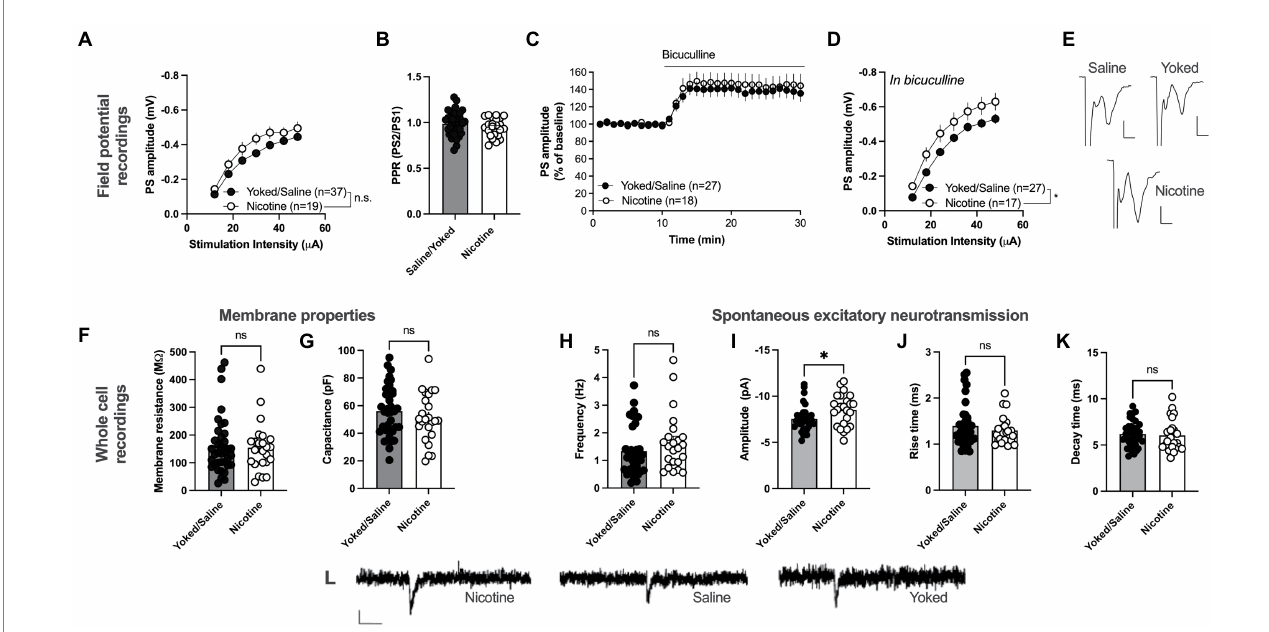
FIGURE 3 Nicotine SA increases excitatory neurotransmission in nAcS MSNs. (A) Field potential recordings demonstrated a trend toward potentiated stimulus– response curves in brain slices from nicotine-SA rats. (B) PPR was not modulated by nicotine-SA. (C) The GABAA receptor antagonist bicuculline disinhibited evoked potentials to a similar extent in both treatment groups. (D) Isolation of excitatory currents revealed a significantly enhanced stimulus– response curve in brain slices from nicotine-SA. (E) Example traces based on a mean of 5 traces at baseline for each treatment group. Calibration: 2 ms, 0.2 mV. (F,G) Membrane properties were not significantly modulated by treatment. (H–K) Recordings of spontaneous activity demonstrated a significant increase in sEPSC amplitude, indicating that nicotine-SA increases MSN responsiveness to excitatory inputs. (L) Example traces showing recorded sEPSCs in brain slices from all treatment groups. Calibration: 10 pA, 50 ms. Values are presented as mean (±SEM), n = number of slices, taken from at least four animals. * p < 0.05.